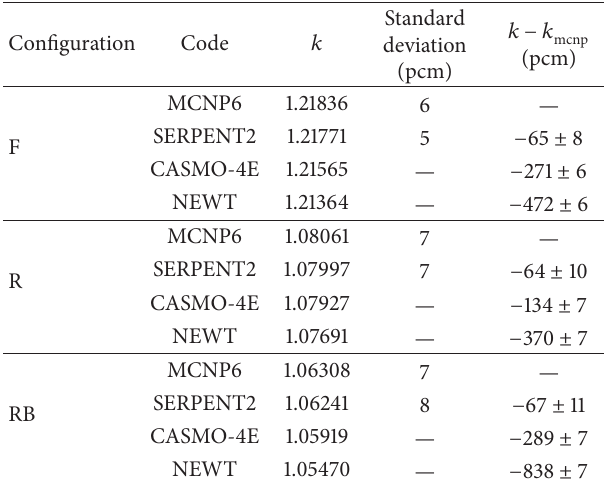
Table 3: The eigenvalue of unit models for two-step modeling